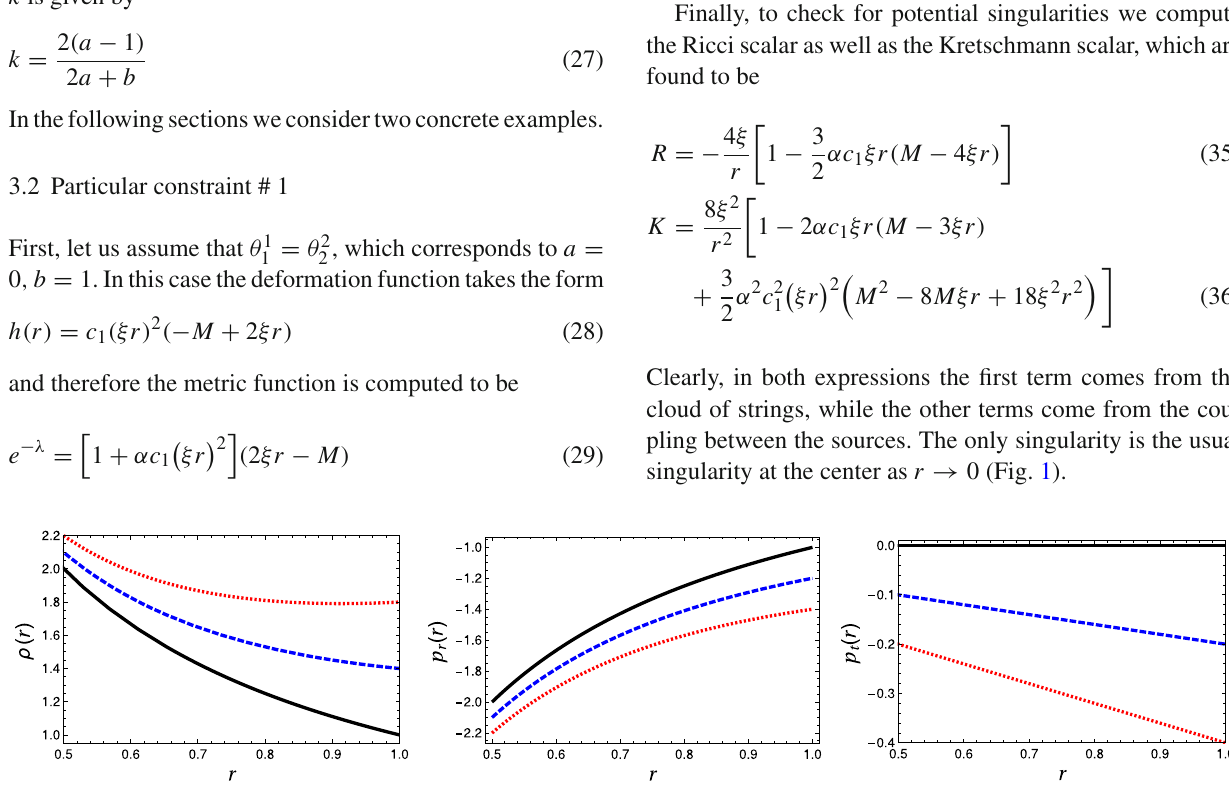
α . Right panel: Tangential pressure p t vs radial coordinate r for differ- ent values of the parameter α . Shown are: (i) α = 0 (solid black line), (ii) α = 0 . 2 (dashed blue line) and, (iii) α = 0 . 4 (dotted red line). The other two parameters have been taken equal to unity, M = ξ =